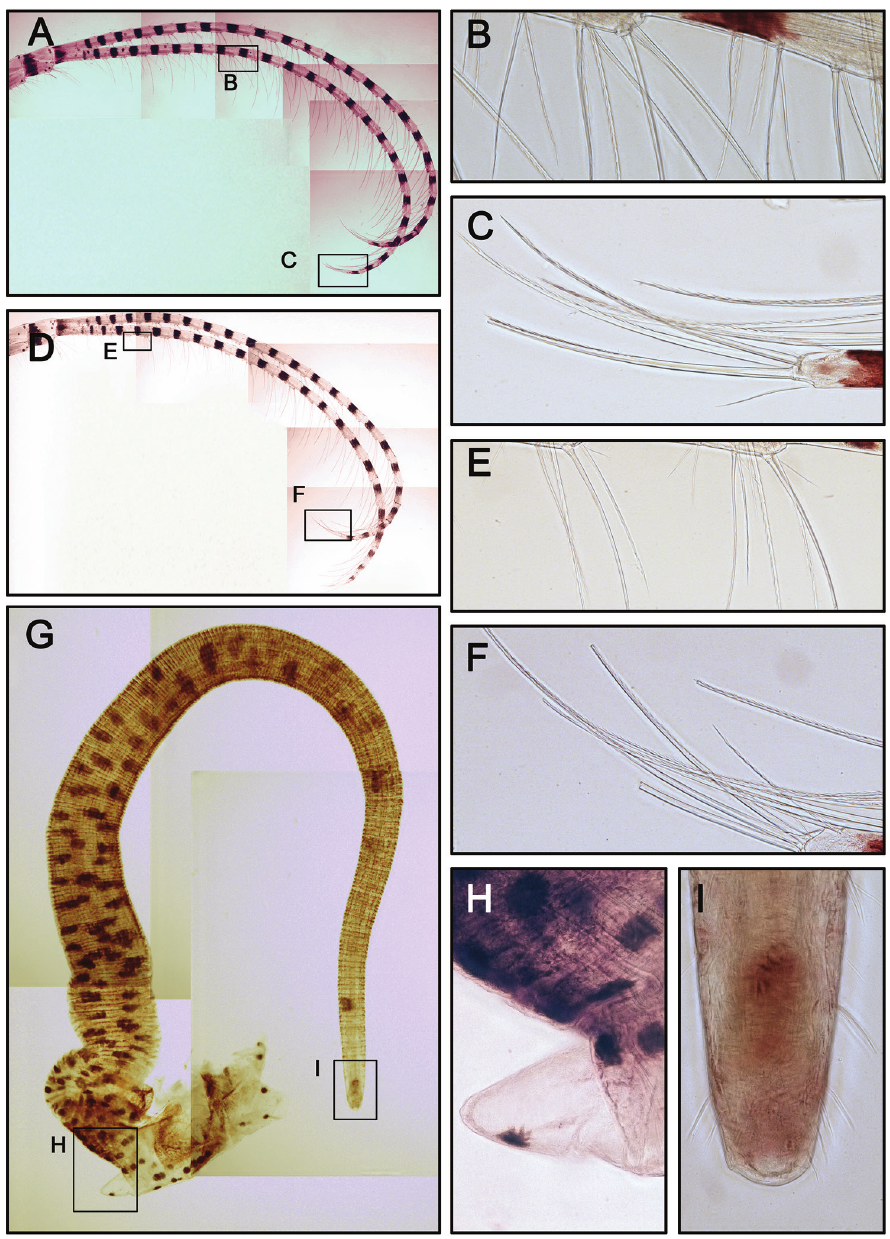
Figure 9. Cirrus V, VI and penis of Galkinius maculosus sp. n. A Cirrus V, with stripes on each seg- ment, rami almost equal length (ASIZCR000343) B Intermediate segment with 4 pairs of serrulate setae C Serrulate setae on the distal segment of anterior ramus D Cirrus VI, with stripes on each segment, rami almost equal length (ASIZCR000343) E Intermediate segment with 4 pairs of serrulate seta F Serrulate setae on the distal segment of posterior ramus G Penis with dark spots (ASIZCR000343) H Basi-dorsal point of penis I Apex of penis with short simple setae. Scale bars in